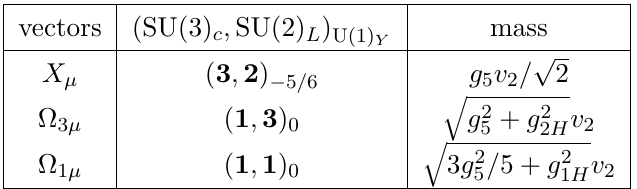
Table 2. The mass spectrum of the gauge bosons. X µ , Ω 3 µ and Ω 1 µ are the SU(5) gauge fields, SU(2) H gauge fields, and U(1) H gauge fields